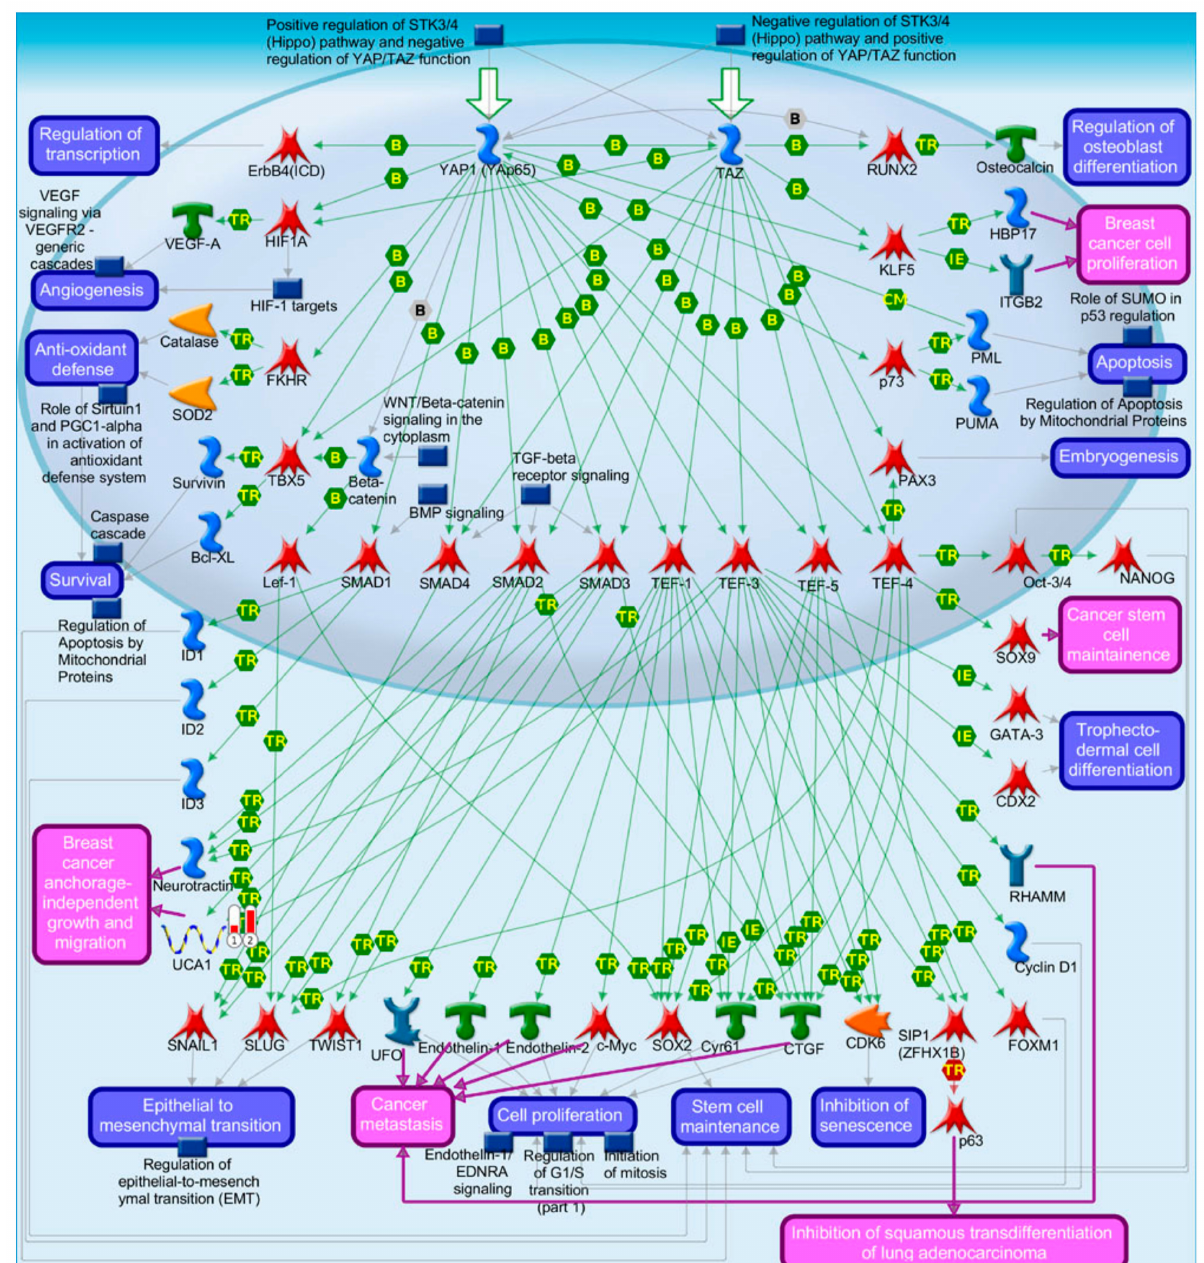
Figure 5. Pathway Map: development: YAP/TAZ-mediated co-regulation of transcription. The lncRNA UCA1 was upregulated by miR-29b-1/a in MCF-7 and LCC9 cells. Image is from MetaCore